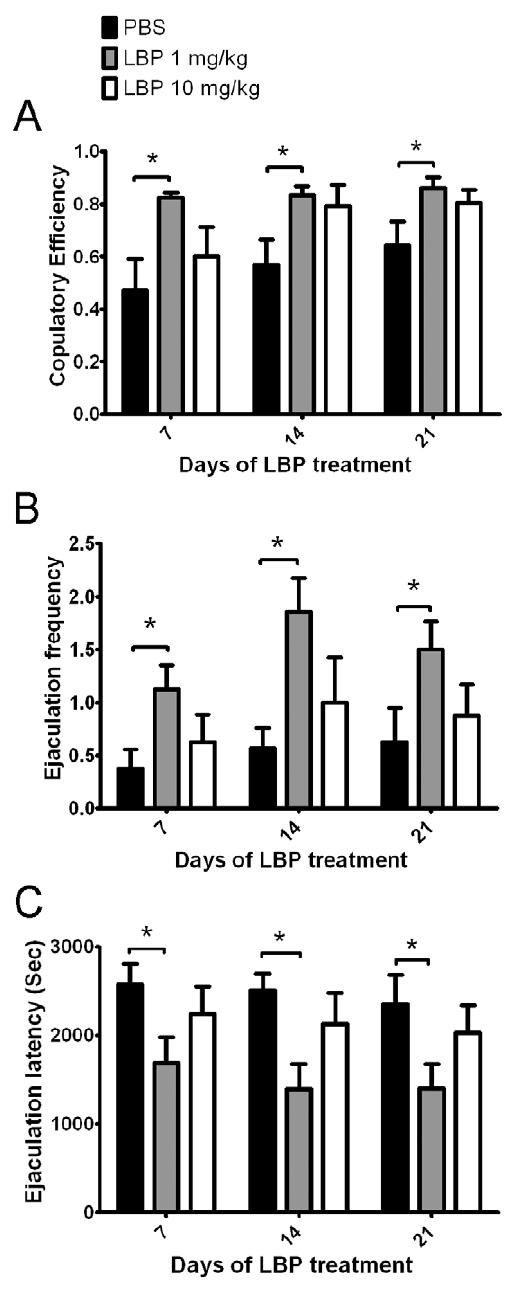
Figure 2. Treatment of LBP at 1 mg/kg improved male sexual behavior in (A) Copulatory Efficiency, (B) Ejaculation Frequen- cy and (C) Ejaculation Latency. No difference was found between vehicle (PBS) group and LBP-treated group (10 mg/kg). Data are presented as mean + SEM. *: p , 0.05, ANOVA with LSD post-hoc test.